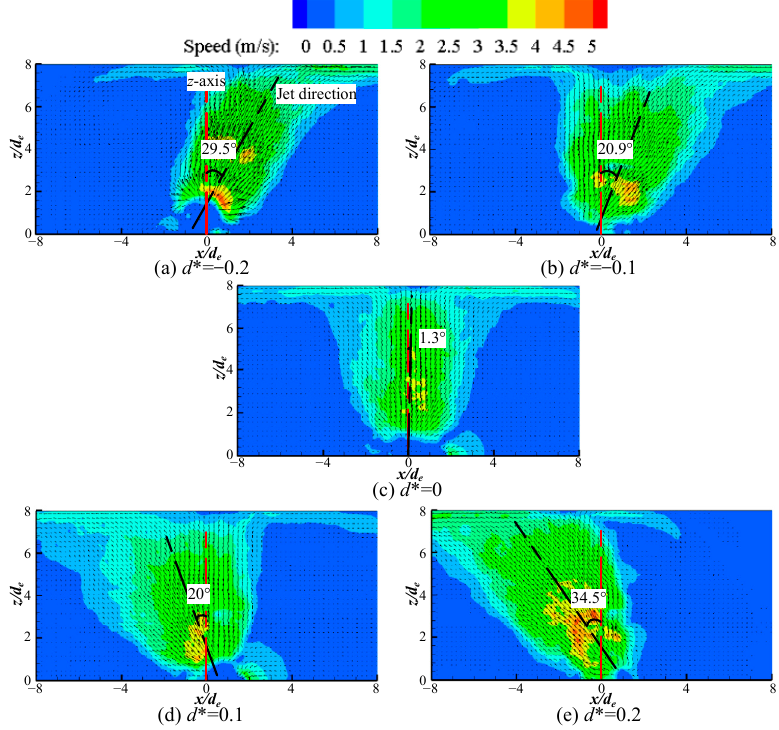
Figure 2. Velocity vector maps, contours, and vectoring angles at different slider locations.